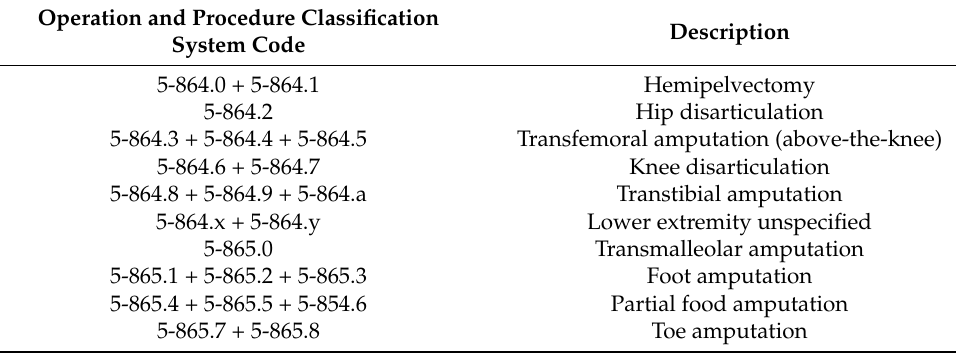
Table 1. Operation and Procedure Classification System code